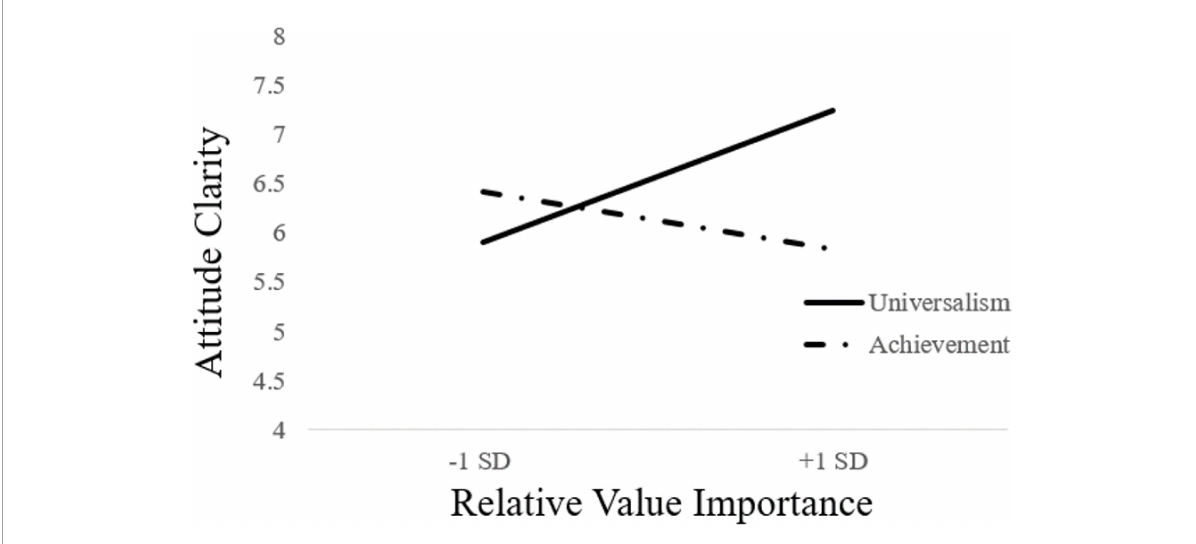
FIGURE1 Study 2 value type × relative value importance effect on attitude